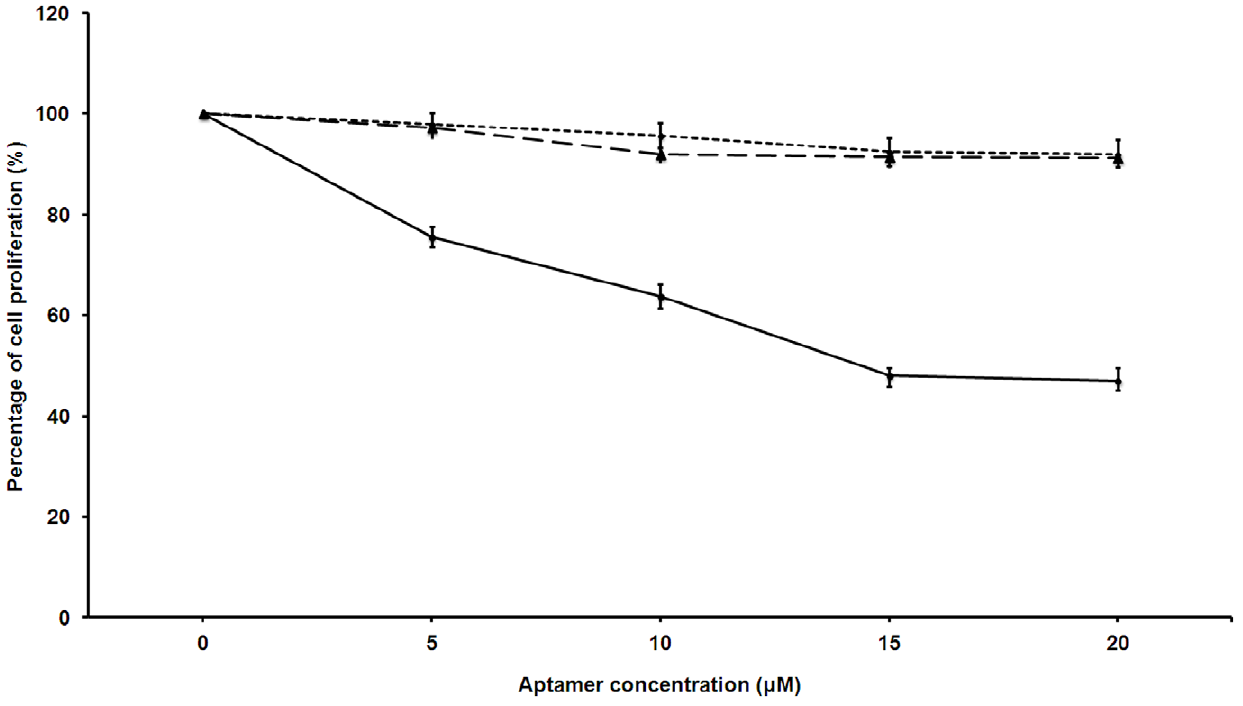
Figure 5. Relative % proliferation of Hep G2 cells (compared to control) after treating with unmodified and PS-modified SL 2 -B aptamers at different concentrations in hypoxia conditions. The sequence specificity was determined using scrambled sequence for PS- modified SL 2 -B for each data point at same concentration to the modified SL 2 -B. Solid line is PS-modified SL 2 -B, dashed line is unmodified SL 2 -B, and dotted line is scrambled sequence.